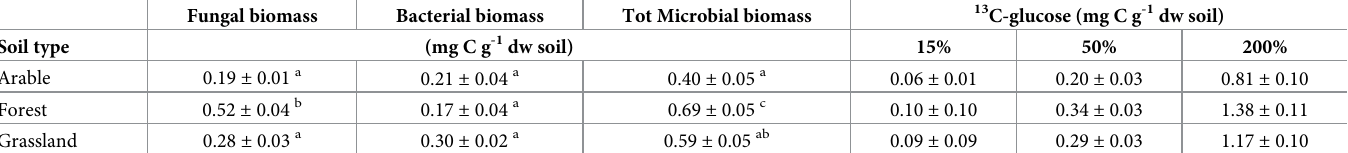
Table 2. Mean values ( ± SE) of initial fungal and bacterial biomass (mg C g -1 dw soil) of the sampled soils and amount of 13 C-glucose added (mg C g -1 dw soil) to the soils in a quantity of C equal to 15%, 50%, and 200% of the microbial biomass carbon. Fungal biomass Bacterial biomass Soil type Arable Grassland Statistically significant differences (P < 0.05) are marked with different letters. Fungal and bacterial biomass are estimated on basis of ergosterol (fungal) and qPCR- 16SrDNA